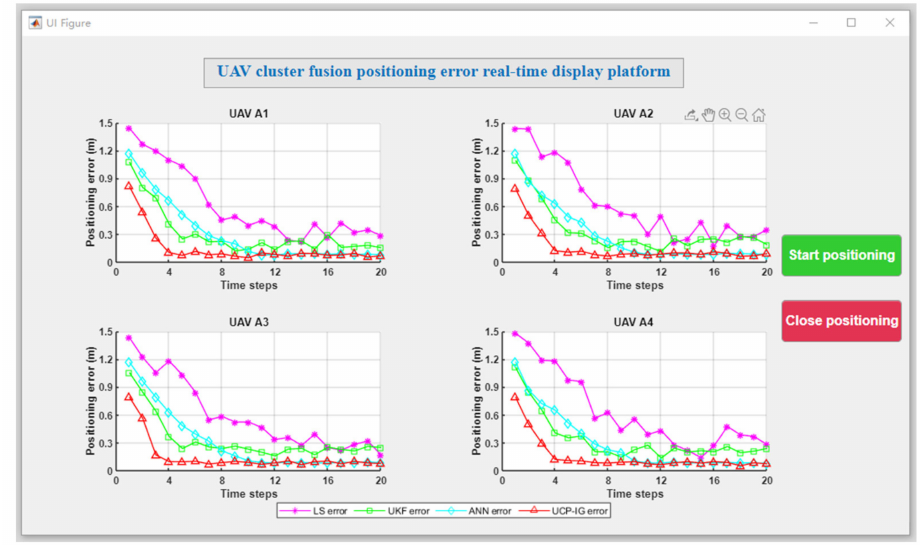
Figure 10. GUI positioning error display platform (experimental random